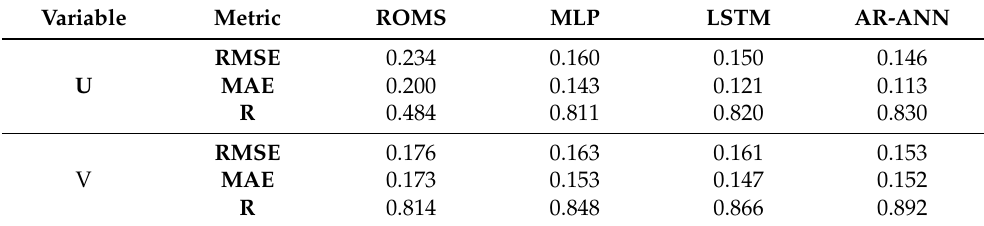
Table 2. Error metric for tidal current speed